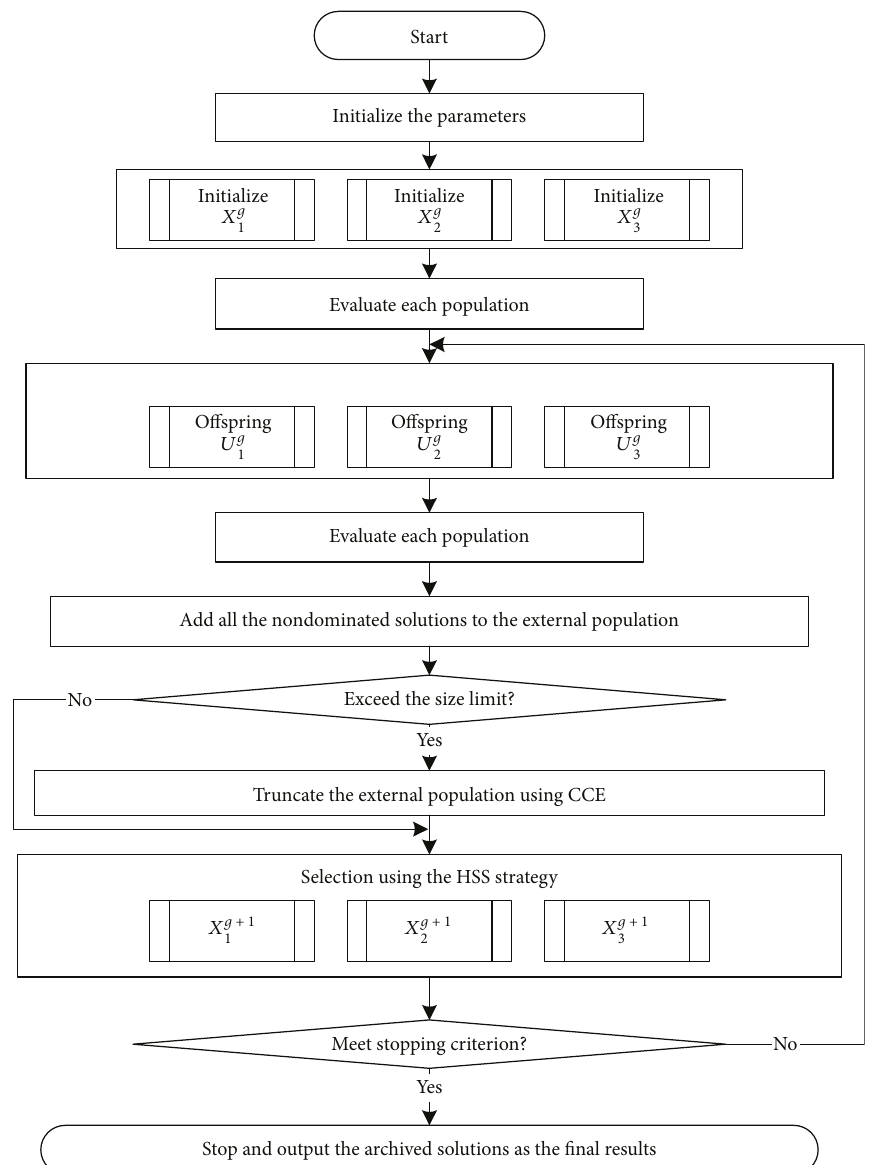
Figure 2: The fl owchart of